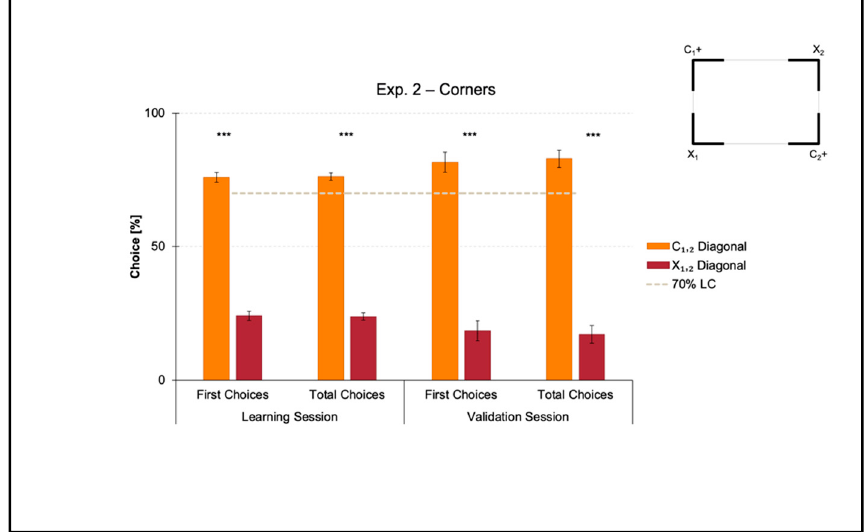
Figure 4. Results of Experiment 2. The bar chart shows the percentages of first and total choices (mean, SEM) obtained by fish towards the two diagonals (C 1,2 versus X 1,2 ) in both learning and validation sessions. The gray dashed line represents the 70% learning criterion (LC), while the asterisks (***) indicate a p- value ≤ 0.001.